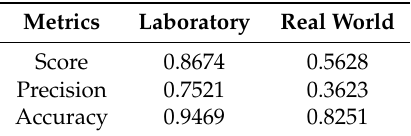
Table 1. Comparison between “conditioned” setup and real world